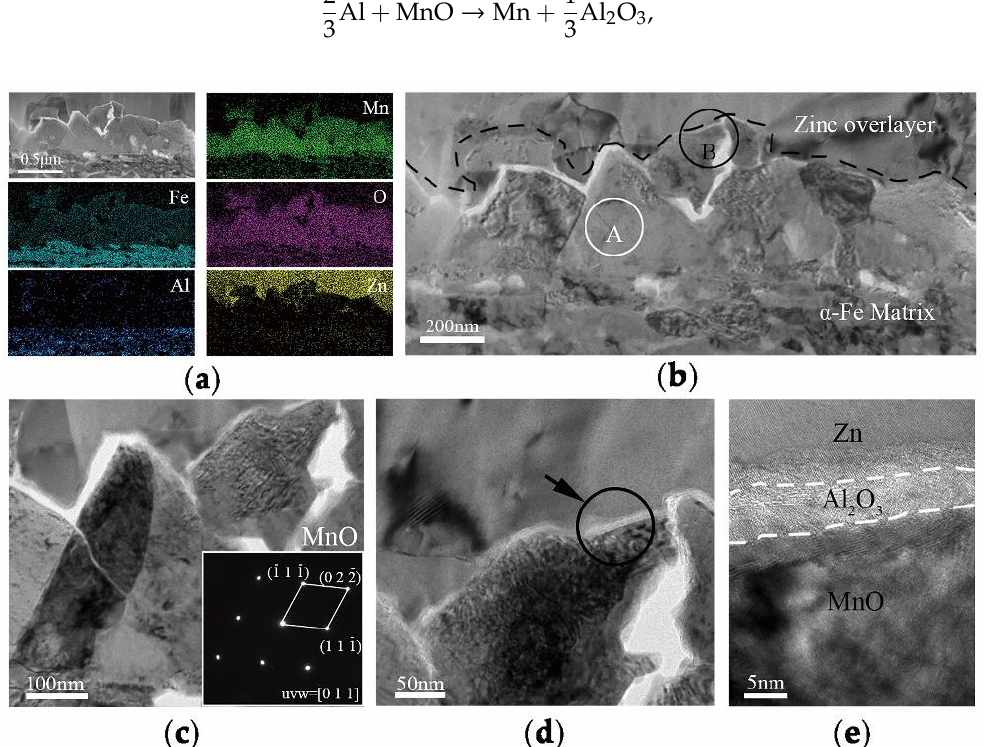
Figure 5. ( a ) STEM cross-sectional elemental maps of the coating / substrate interface and subsurface of the galvanized 10Mn steel annealed under the 283 K (+10 °C) DP process atmosphere. ( b ) TEM micrograph of the area shown in ( a ). ( c ) Enlargement and diffraction pattern of the MnO corresponding to zone A in ( b ). ( d ) Enlargement of the area corresponding to zone B in (b). ( e ) Enlargement of the area corresponding to circle region in ( d ).